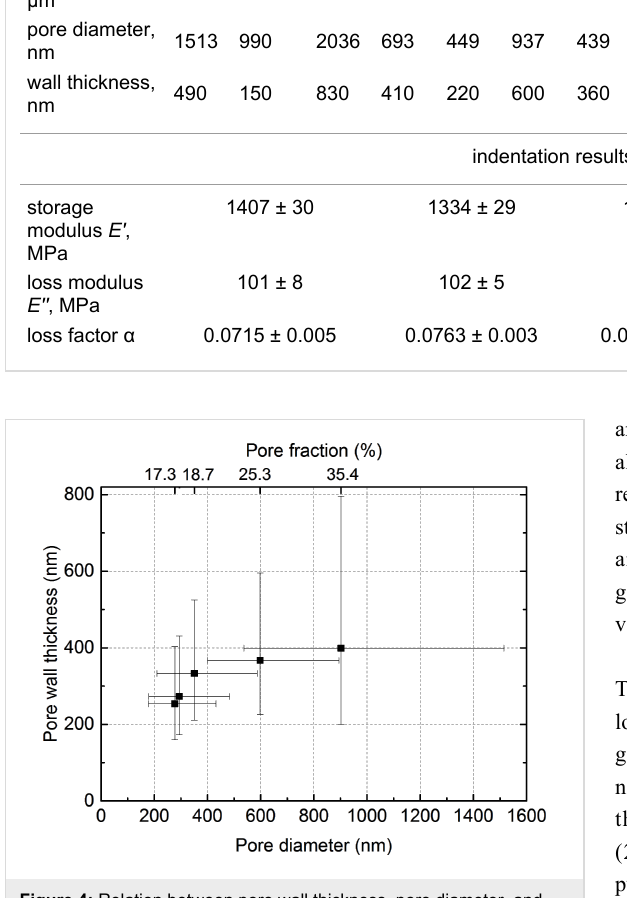
Figure 4: Relation between pore wall thickness, pore diameter, and pore fraction in micro-to-nanocellular PMMA. In the prepared porous sample all mentioned parameters decrease during the transition from macro- to nanocellular PMMA.